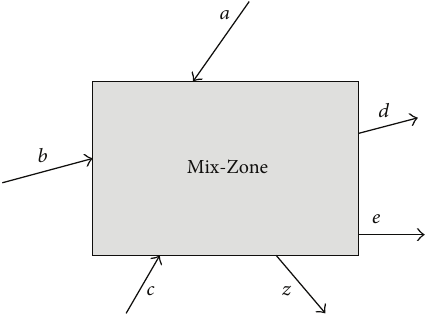
Figure 2: Identification of Mix-Zone with traffic